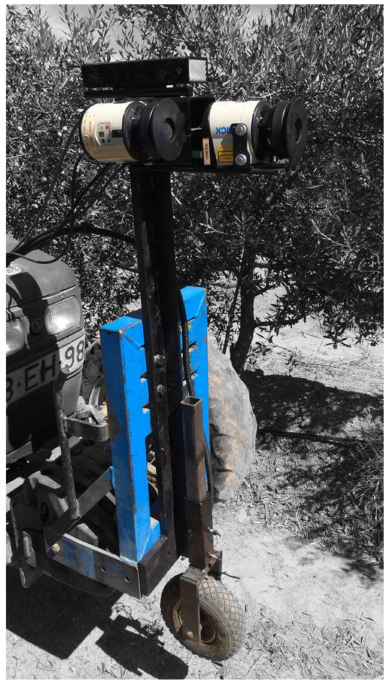
Figure 2. Two LiDAR sensors were mounted on the front of the tractor in different orientations to scan the olive tree